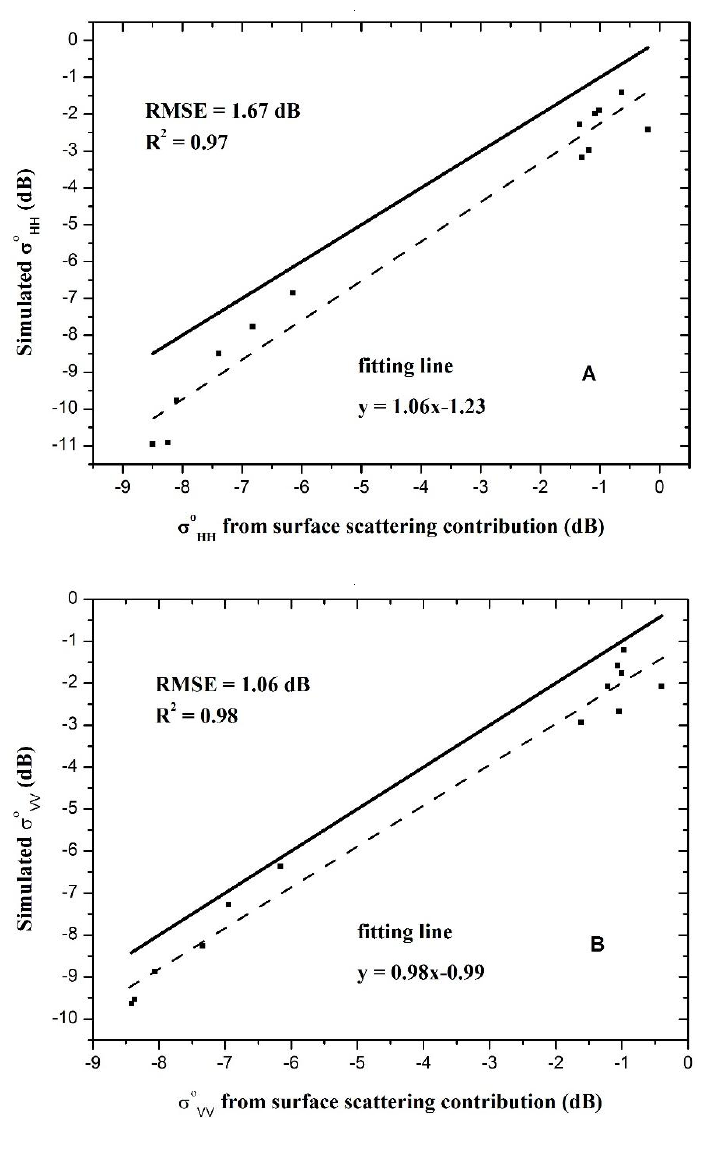
Figure 6. Comparison between σ° from the surface scattering contribution using eigenvector-eigenvalue based decomposition and simulated results using the two-layer scattering model. Two scenes of ALOS-PALSAR polarimetric data (L-band, quad-polarization, 23.9° and 25.6° incidence angles for 19 April and 6 May 2009) were used. A and B are for HH and VV polarization, respectively, with RMSE, R square and linear fitting formula shown. The solid line in each diagram accounts for the 1:1 line, and the dashed line represents the linear fitting